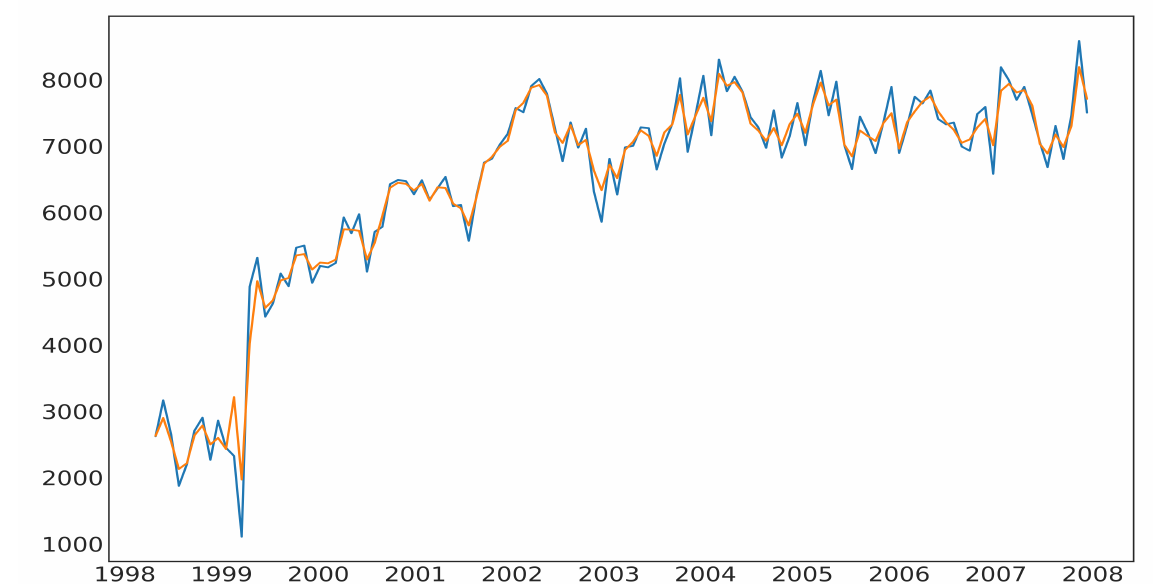
Figure 4. Forecasted values for crime by a random forest